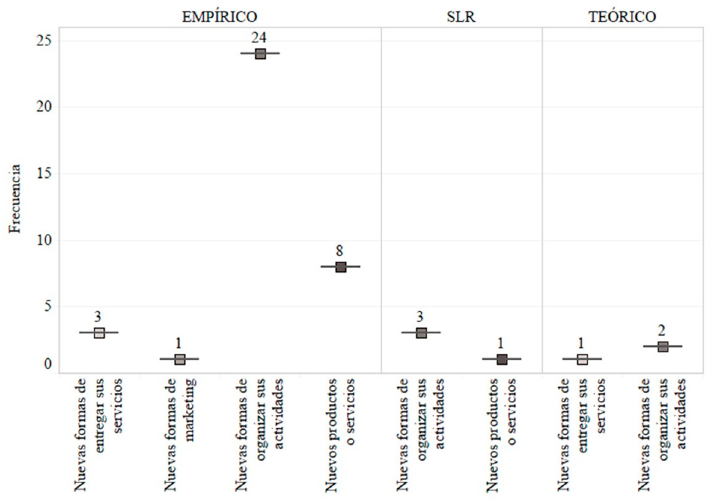
Figure 5. Type of innovation and studies identified in the systematic mapping of literature. Own